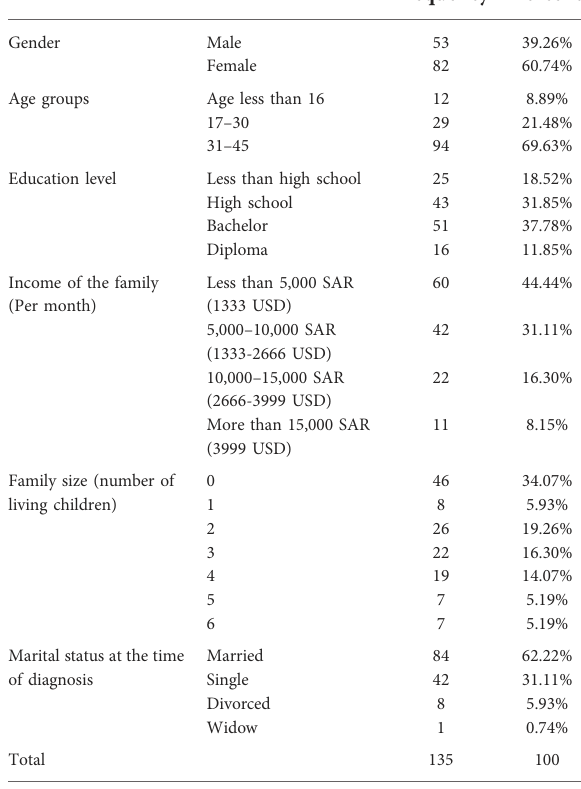
TABLE 1 Sociodemographic characteristics of patients.